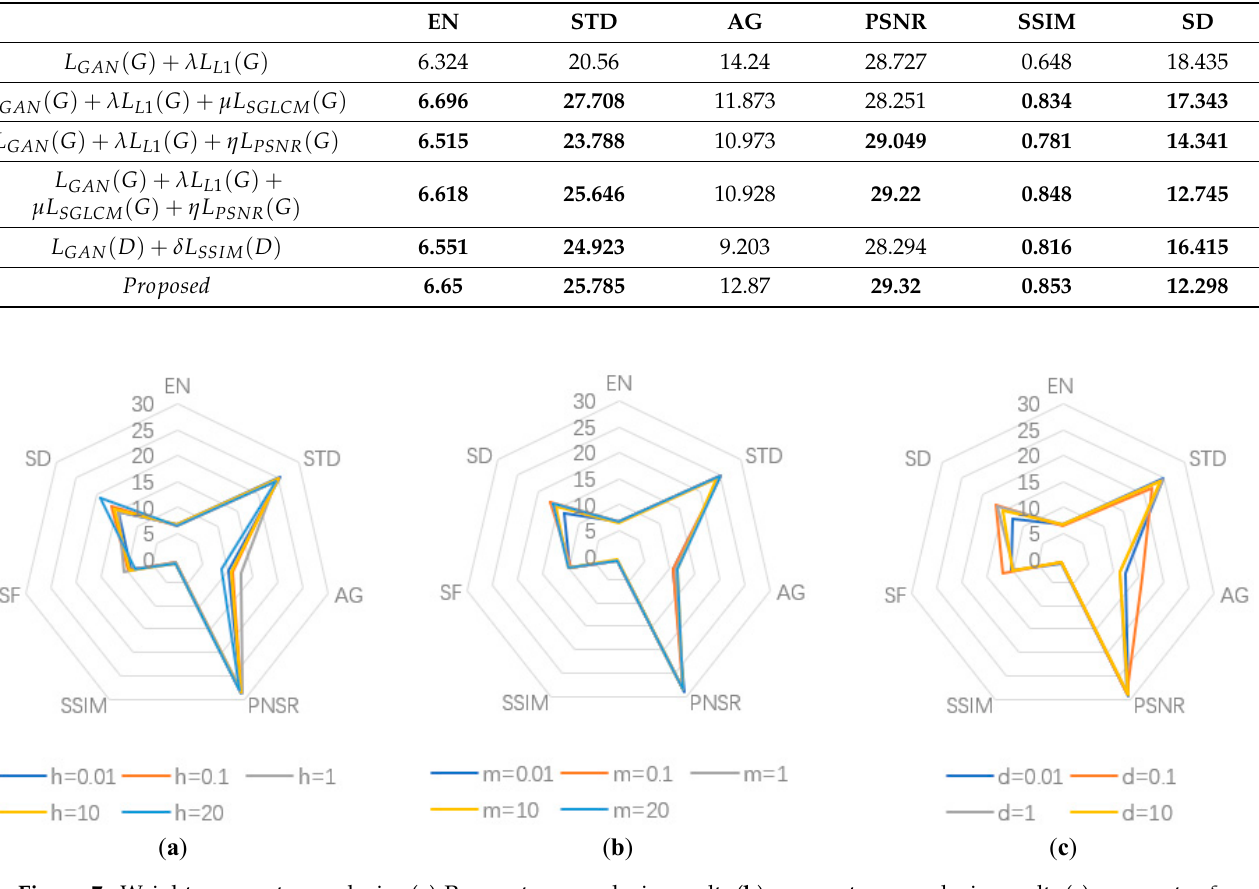
Figure 7. Weight parameter analysis. ( a ) Parameter η analysis result; ( b ) parameter µ analysis result; ( c ) parameter δ analysis